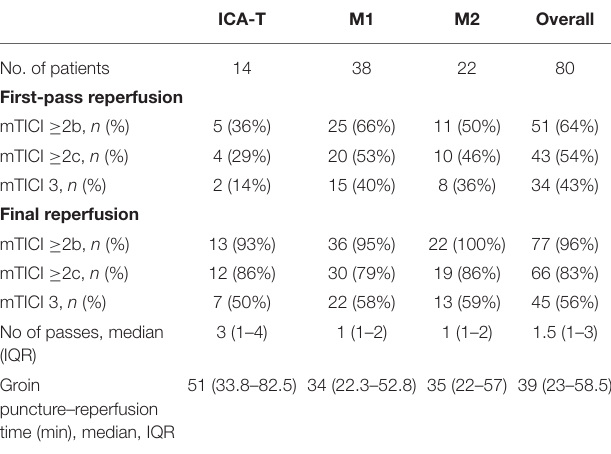
TABLE 1 | Baseline characteristics of the patients. TABLE 2 | Angiographic results stratified by occluded vessel and overall vessels.